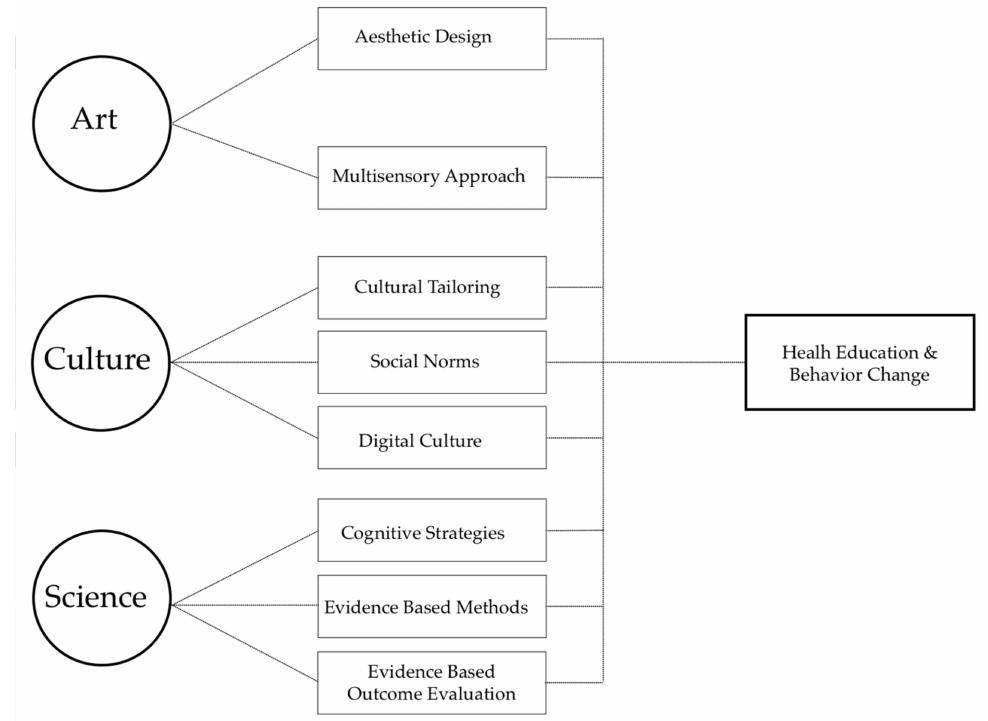
Figure 1. The Multisensory Multilevel Health Education Model.